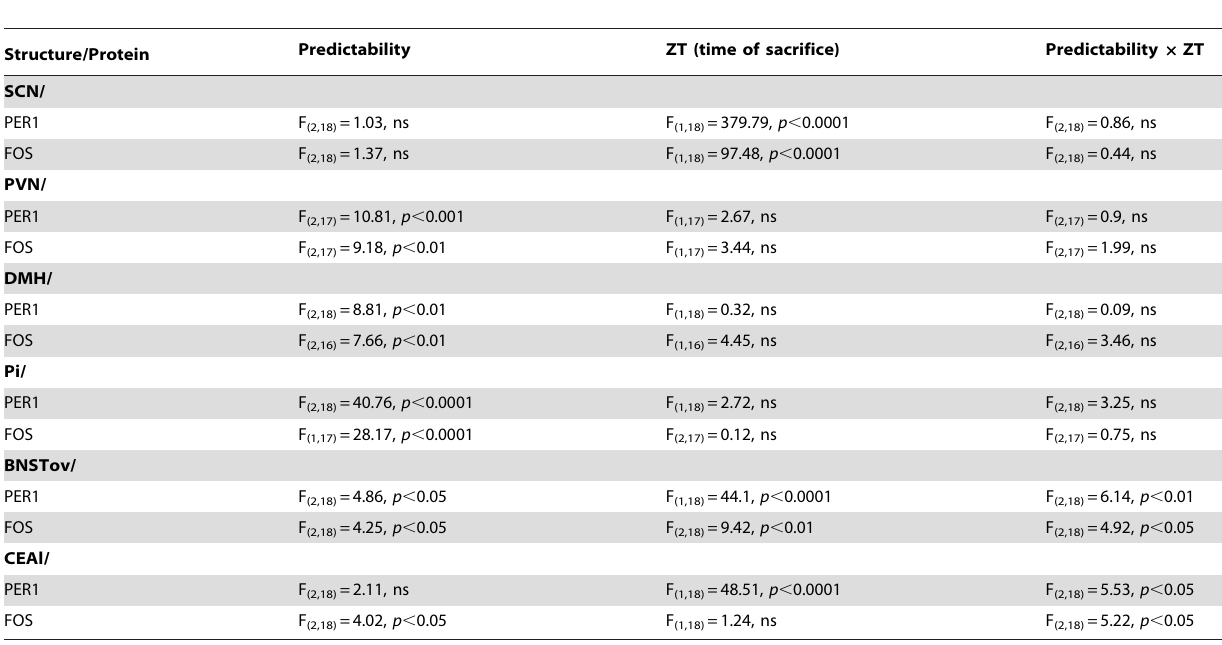
Table 5. Statistical analysis of the effect of repeated daily predictable vs. unpredictable restraint stress and of time of day (ZT) on PER1 and FOS expression in limbic and hypothalamic brain